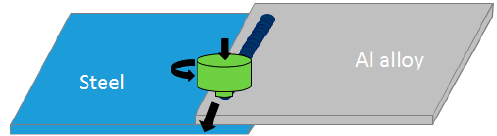
Figure 13. Friction stir welding between steel and aluminum in the lap joint case.